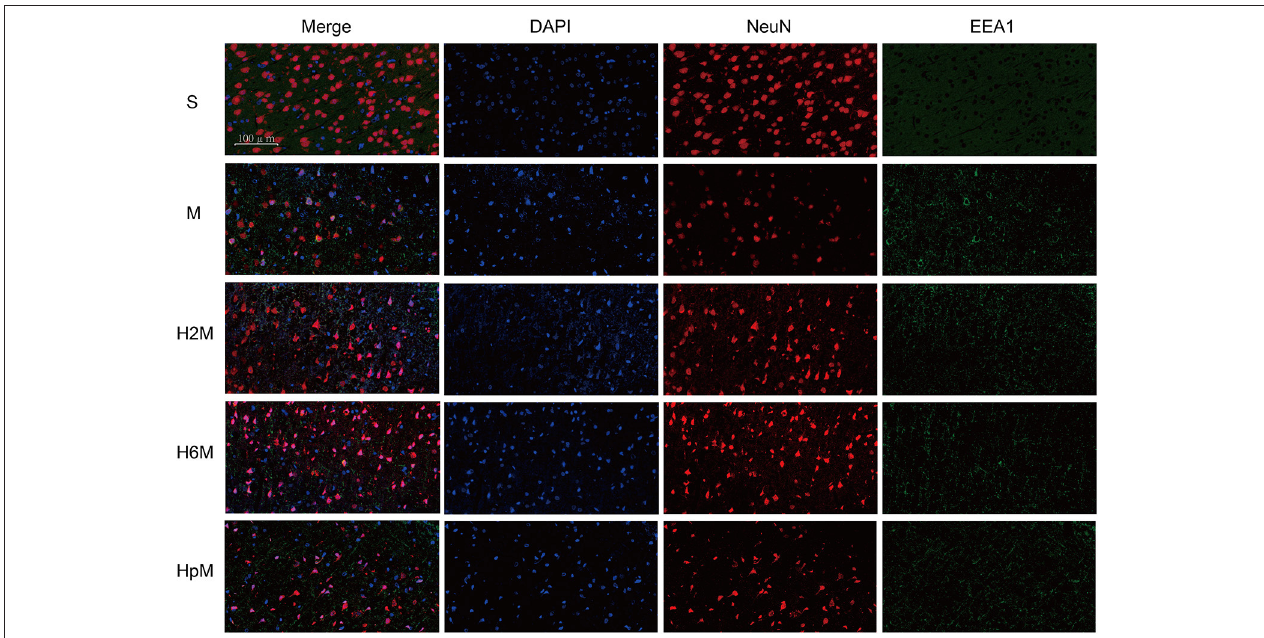
FIGURE 7 | EEA1 and NeuN immunofluorescence double labeling. Neurons in the periinfarct region were co-stained with EEA1 positive staining cells after the MCAO procedure. The remaining neurons in each group showed positive staining of EEA1 in different degrees. Neurons in the four MCAO groups showed EEA1 positive staining, while it was not observed in the sham group. EEA1, Early endosome antigen 1; NeuN, neuron-specific nuclear protein.